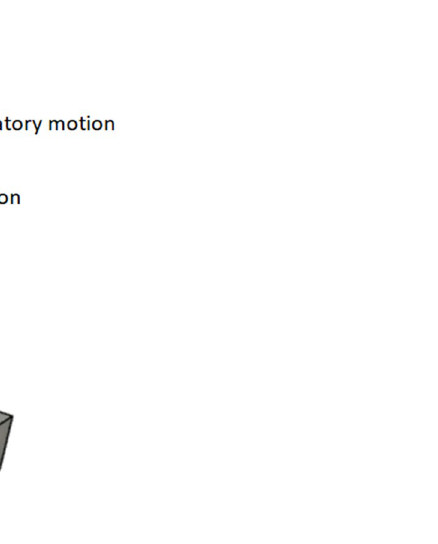
Figure 3. Process principal of